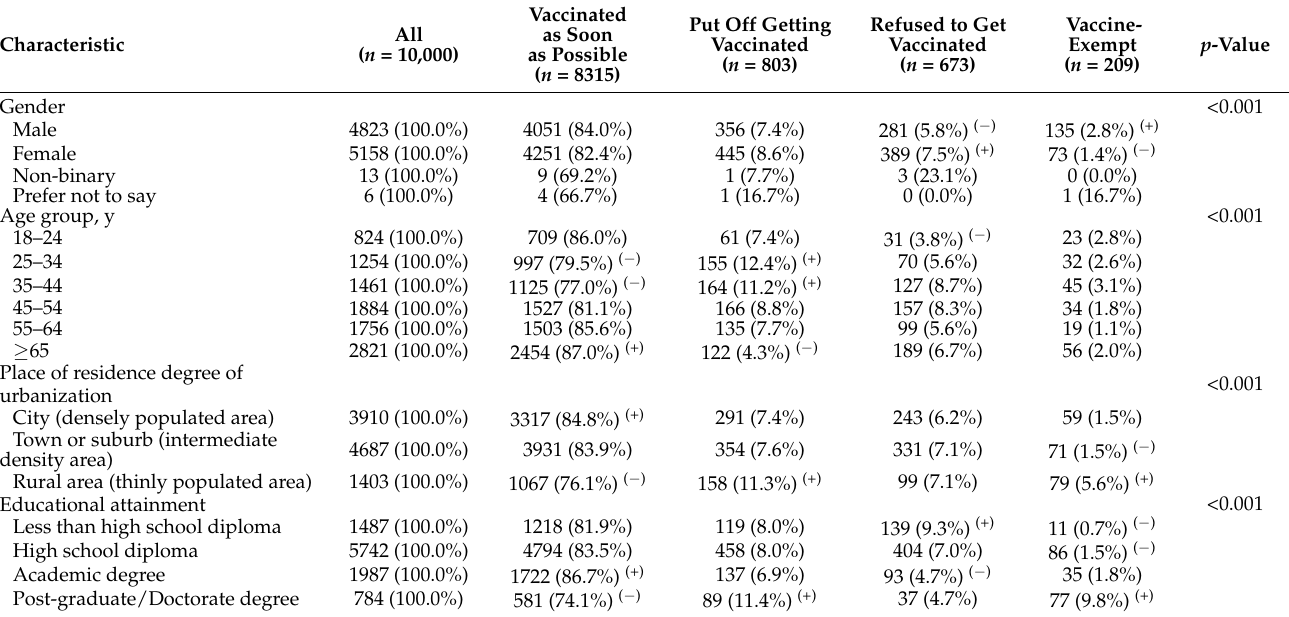
Table 1. Sociodemographic characteristics of the study sample, overall and by COVID-19 vaccine uptake status. Counts and percentages were obtained by weighting all observed values with post- stratification weights based on the distribution of Italy’s resident adult population by NUTS region, gender, and age